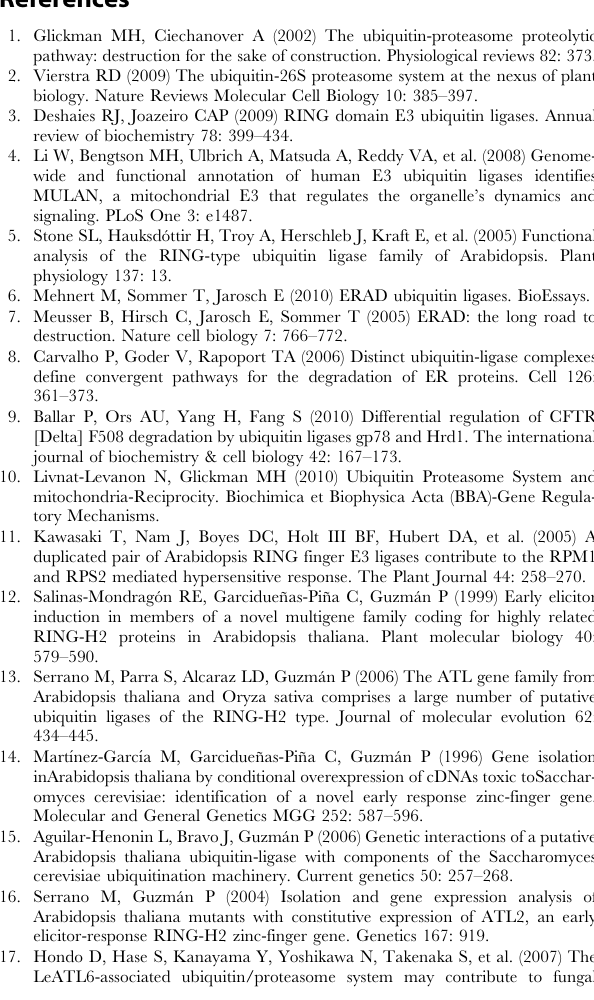
Figure S1 Phylogenetic tree of ATLs from 24 genomes . The phylogeny was built using FasTree, the likelihood-based local support values above 80% is depicted by dots and the domain architecture based on sequence LOGOs is depicted in each branch. Figure S2 Divergent Tandemly arrayed ATLs. Chromo- somal location and domain architecture based on sequence LOGOs of pairs of tandemly arrayed ATLs that are not in the same monophyletic group. A, pairs positioned in groups D and H; B, pairs positioned in groups D and G; C, a pair positioned in groups H and F. Table S1 Number of genes containing a RING-H2 domain or a canonical ATL RING-H2 domain in 24 plant genomes. Classification, species name and the abbrevi- ation for each of the 24 plant species used in this work is displayed. Table S2 Distribution in 9 groups of ATLs retrieved from 24 plant species. tm, number of transmembrane helices predicted by the TMHMM Server v. 2.0.